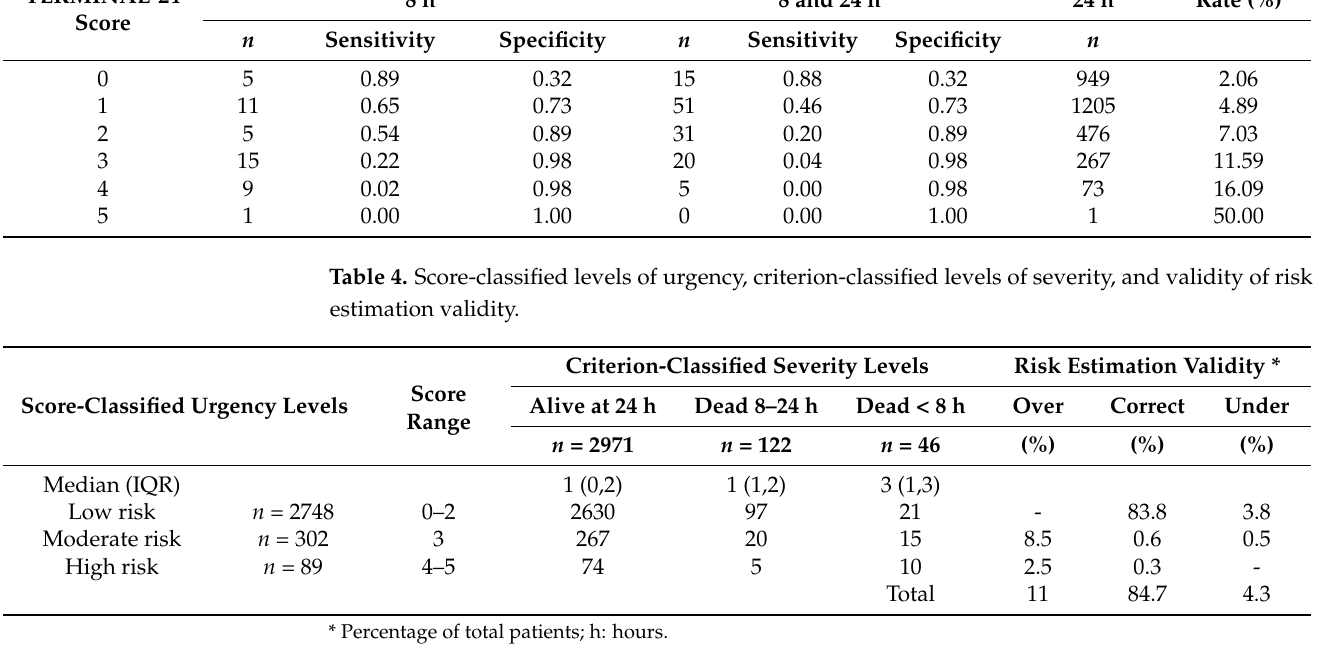
Table 5. Score-classified levels of urgency, criterion-classified levels of severity, likelihood ratio of positive, 95% confidence interval, and p